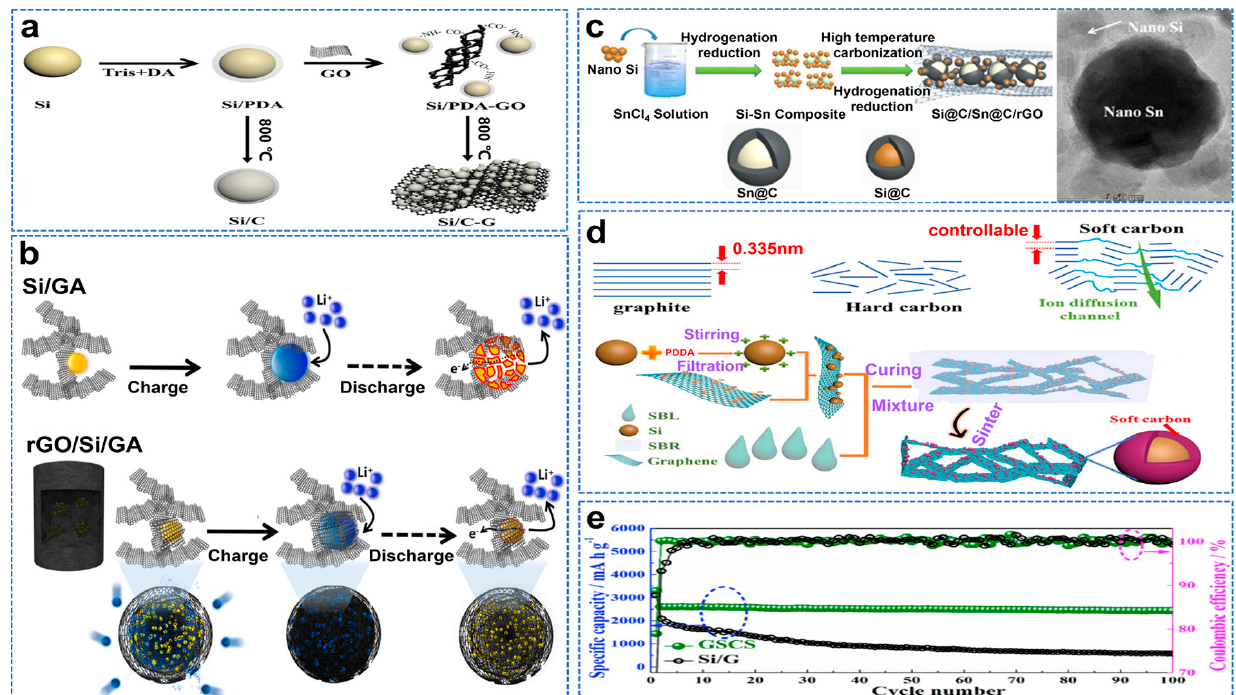
Figure 3. ( a ) Preparation of Si/C − G materials [38]. ( b ) Si/GA and rGO/Si/GA composite anodes before and after lithiation/de − lithiation processes [40]. ( c ) Schematic illustration of the synthesis of Si@C/Sn@C/rGO and TEM images of sample [41]. ( d ) Schematic of preparation of GSCS. ( e ) Cycling performance of GSCS and Si/G at 0.2 A g − 1 [42].